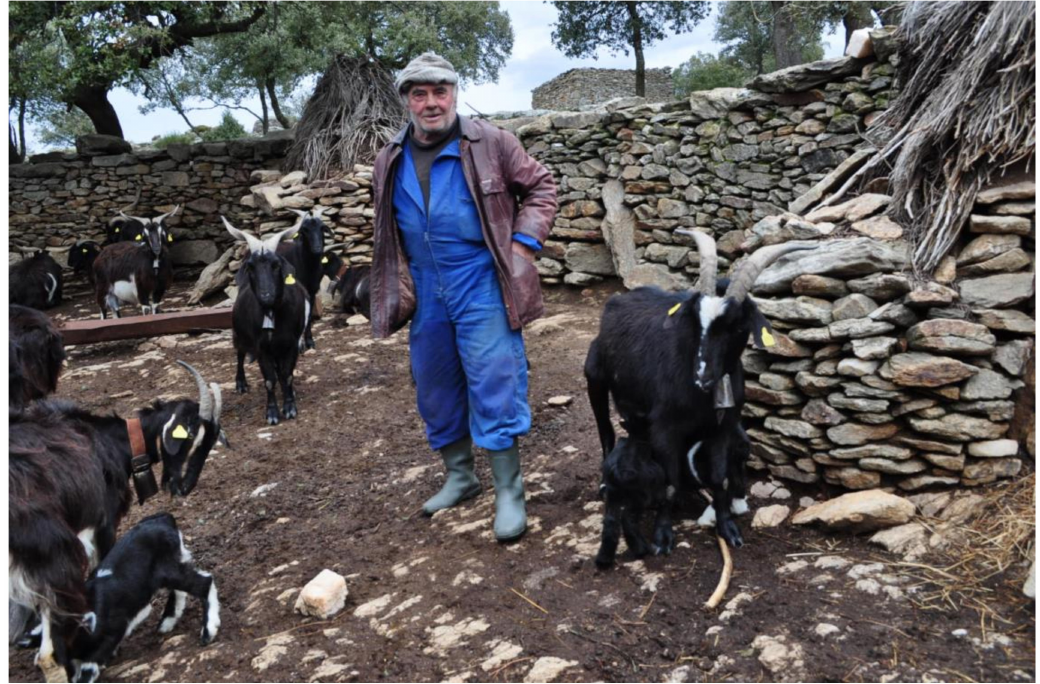
Figure 6. Breeder of the goat breed Agrupaci ó n de las Mesetas in the